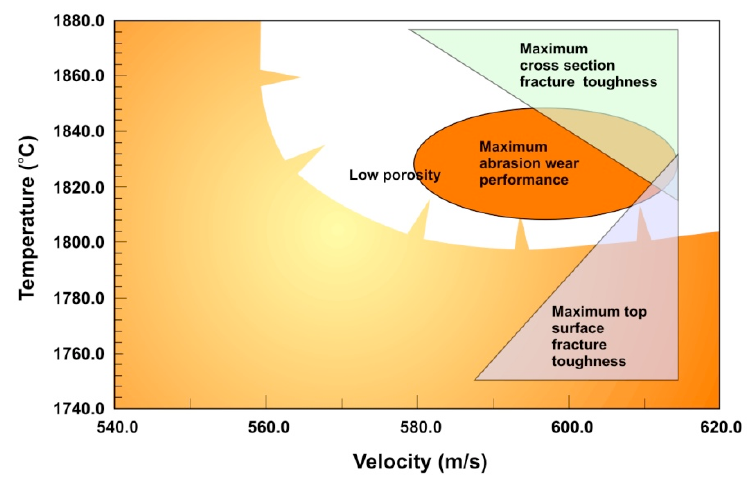
Figure 8. A generalized second order process map for WC-CoCr HVOF coating. Different coating properties are placed into the temperature-velocity diagram. This process map can be used as a design tool to optimize coating process conditions in order to achieve desired coating property or coating property